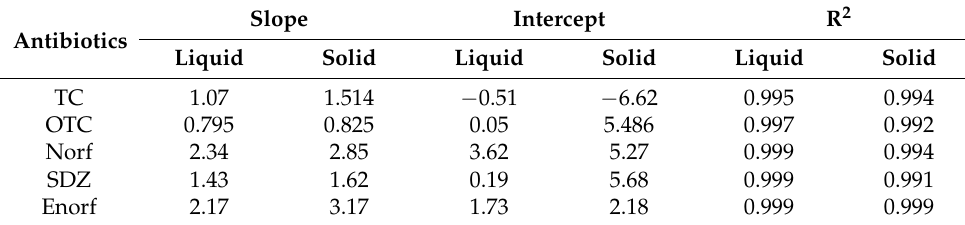
Table 4. Linearity of the suggested